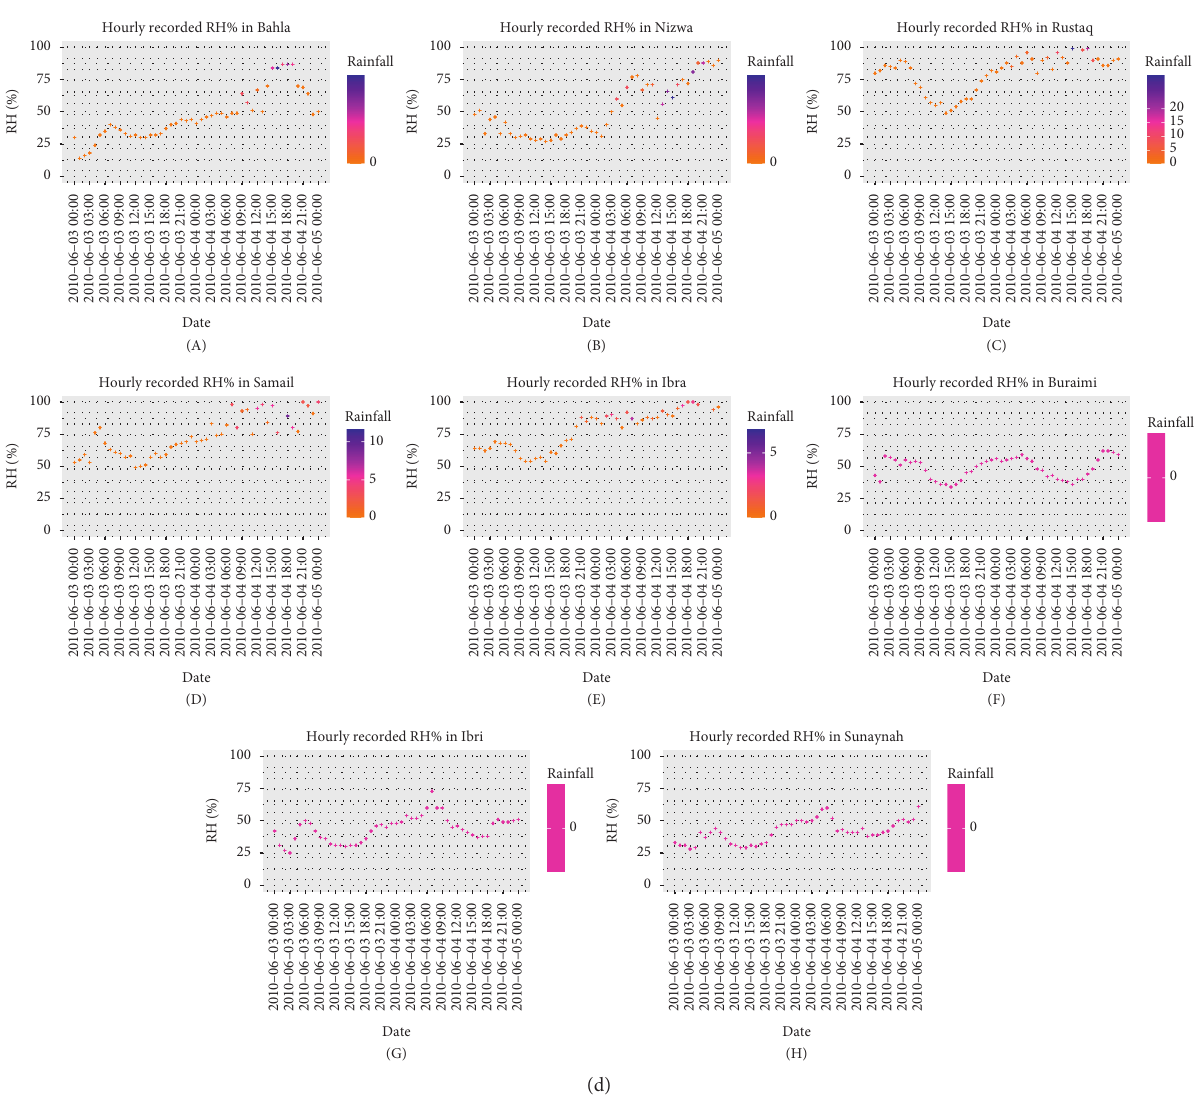
Figure 11: (a) Hourly temperature variation in ° C with respect to the wind direction at some weather stations on the Al-Hajar Mountains during TC “Phet.” (b) Hourly precipitation (mm) at some weather stations on the Al-Hajar Mountains during TC “Gonu.” (c) Daily precipitation (mm) at some weather stations on the Al-Hajar Mountains during TC “Phet.” (d) Hourly RH% variation with respect to the wind direction at some weather stations on the Al-Hajar Mountains during TC “Phet.”